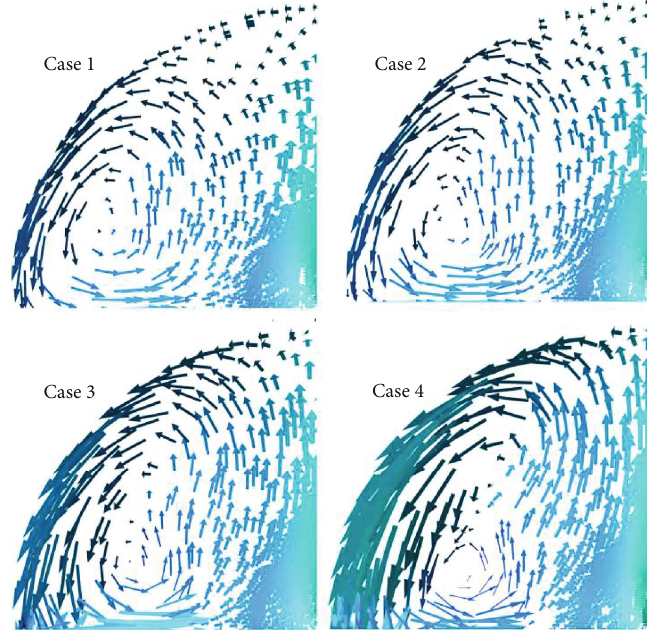
Figure 11: The velocity vector in the section of x = 350mm . The section was at the back side of the air inlet